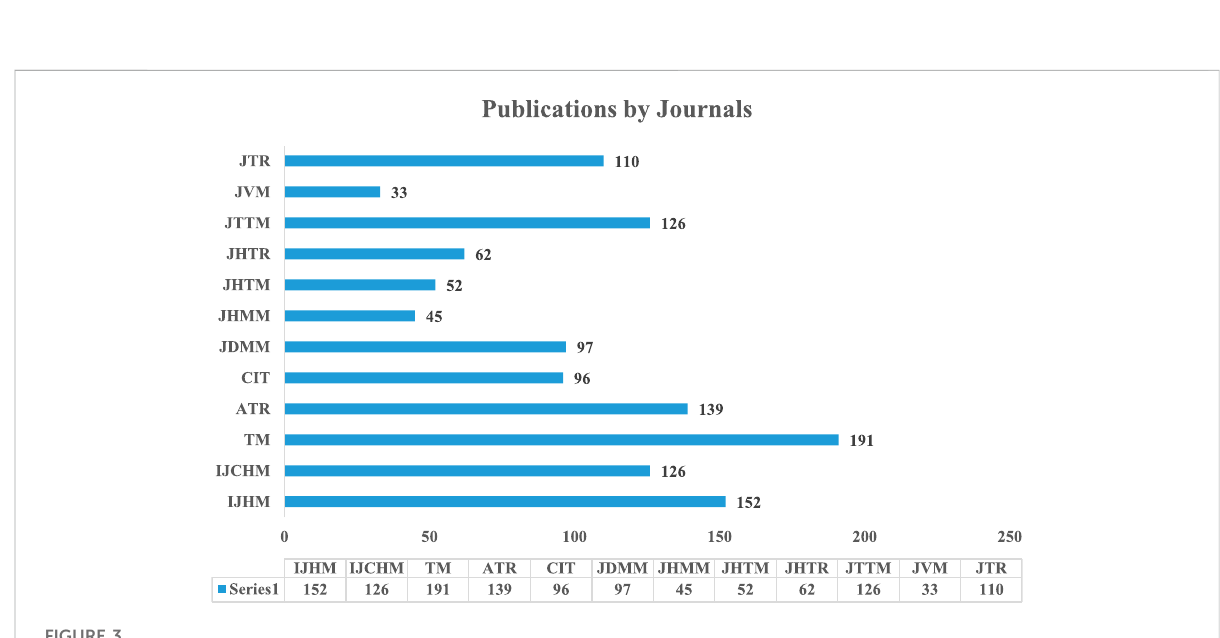
FIGURE 3 Publications by leading